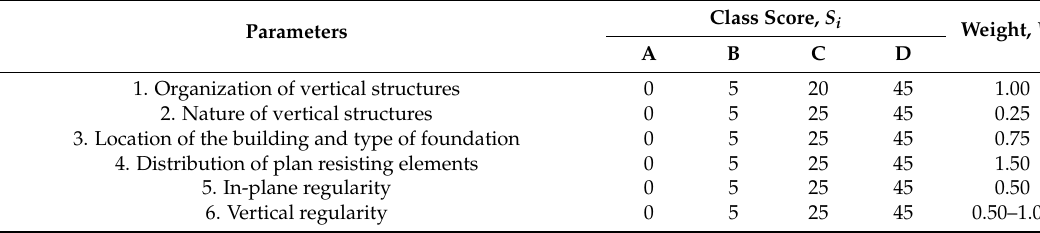
Table 1. The new vulnerability form for building aggregates.